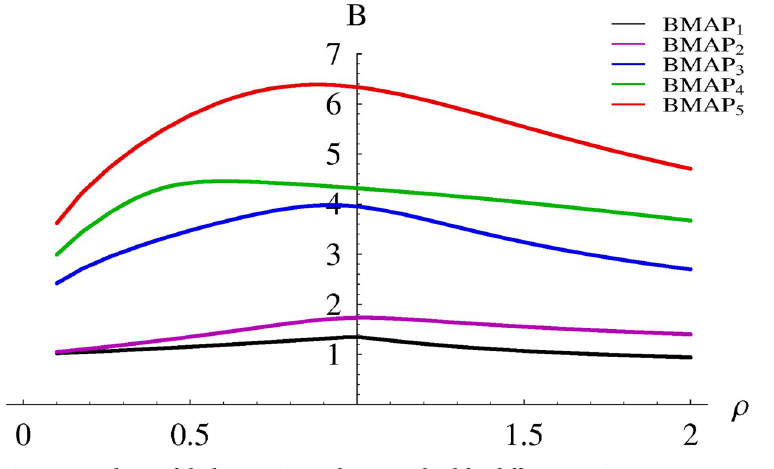
Fig 4. Dependence of the burst ratio on the system load for different